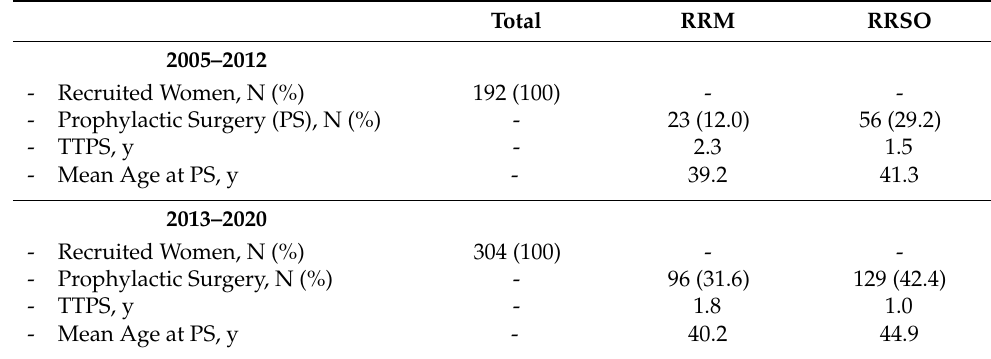
Table 2. Prophylactic Surgeries in BRCA1/2 Carriers in Different Time Periods.